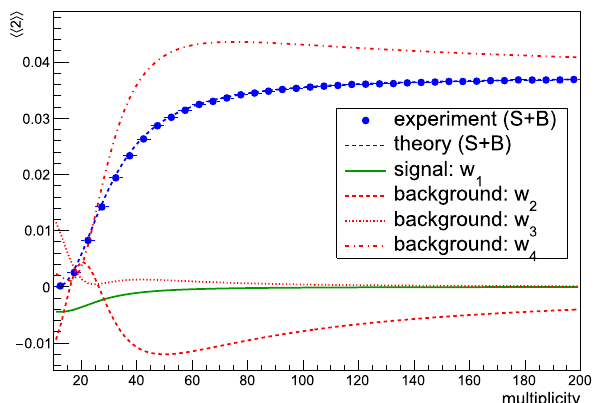
Fig. 3 Analytic description of combinatorial background in two- particle correlations, when particles are produced in pairs, and the final data sample is